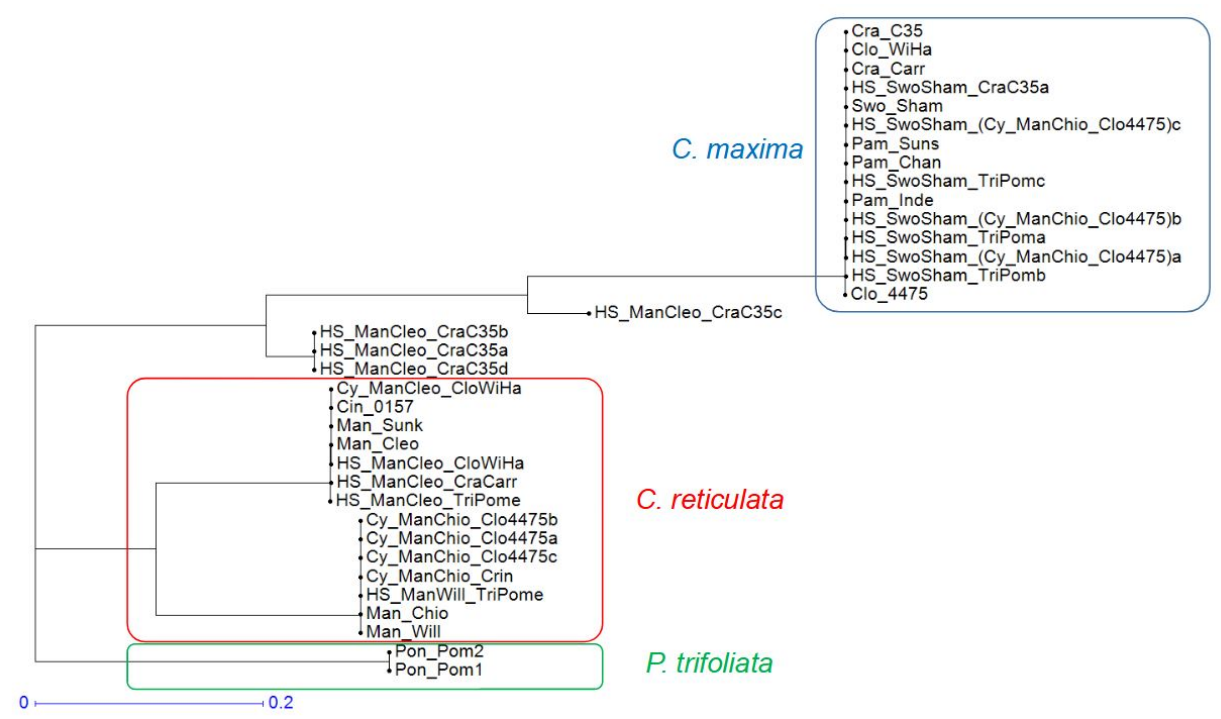
Figure 3. Inheritance of mitochondrial genomes: NJ tree inferred from 24 diallelic